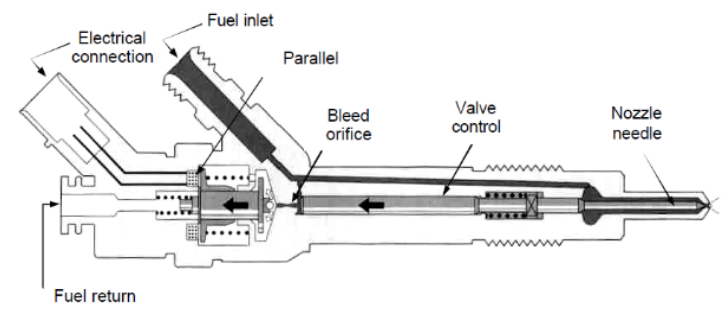
Figure 3. Bosch common rail fuel injector, Bosch (2005).